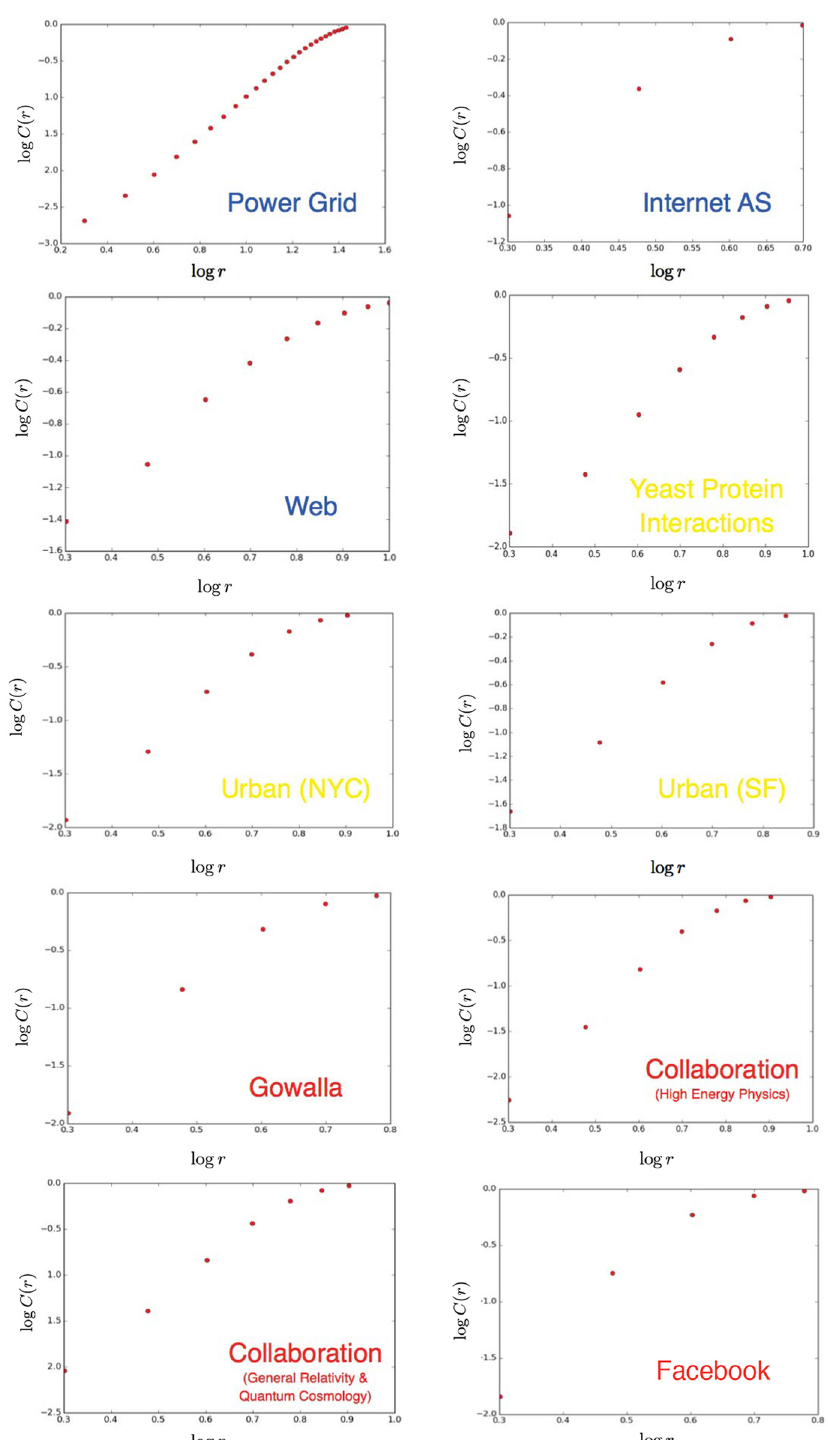
Fig 1. power-hop scaling for our network datasets. The power-hop conjecture appears to be true for all the network datasets we examined despite the fact that they capture completely different network dynamics.